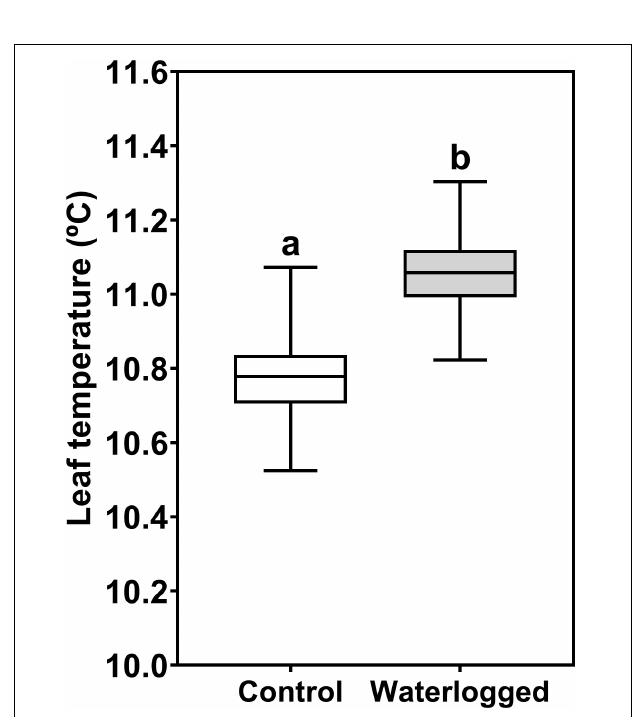
FIGURE 7 | Boxplots of the leaf surface temperature measured through infrared thermography in leaves of control plants (white box) and waterlogged plants (gray box) of Spartina patens after 30 days ( n = 10, different letters indicate significant differences at p <